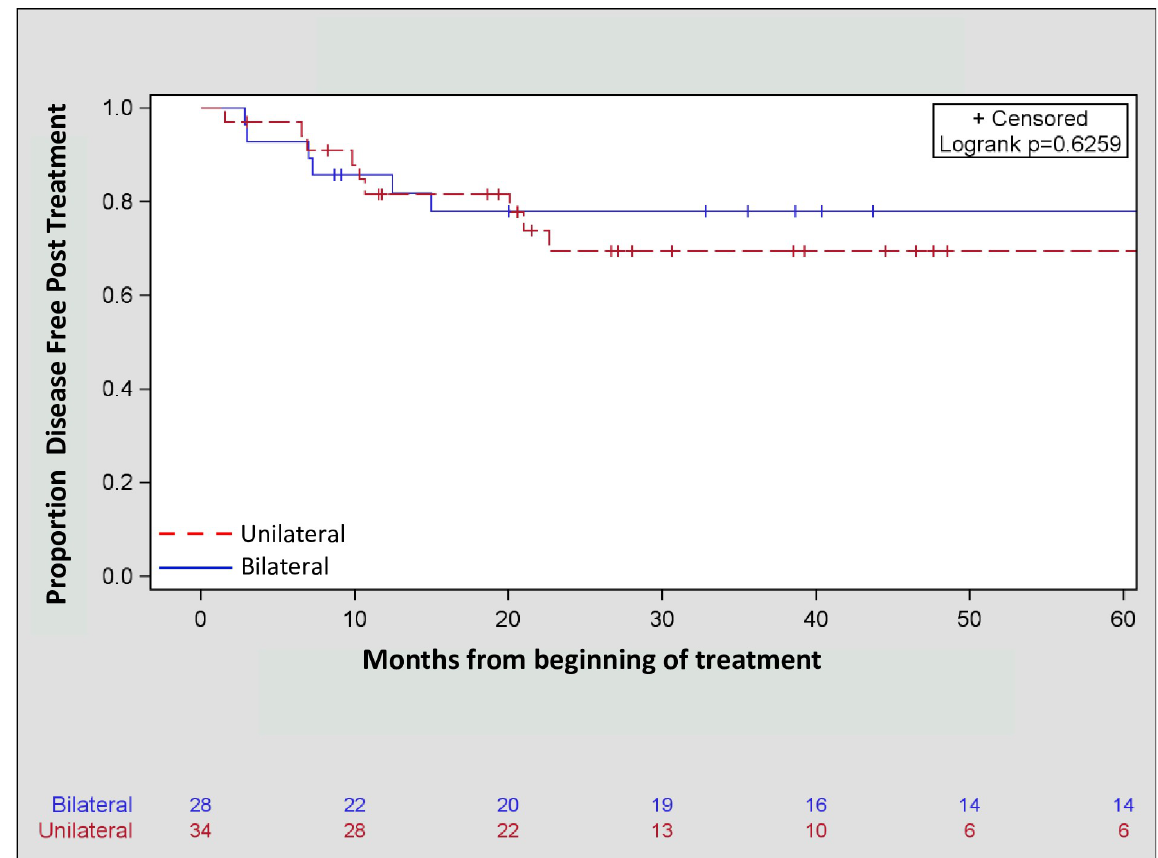
Fig 2. Kaplan Meier three-year disease free survival of unilaterally (69.43%) and bilaterally (77.92%) treated patients with squamous cell carcinoma of the head and neck from an unknown primary (p = 0.63).